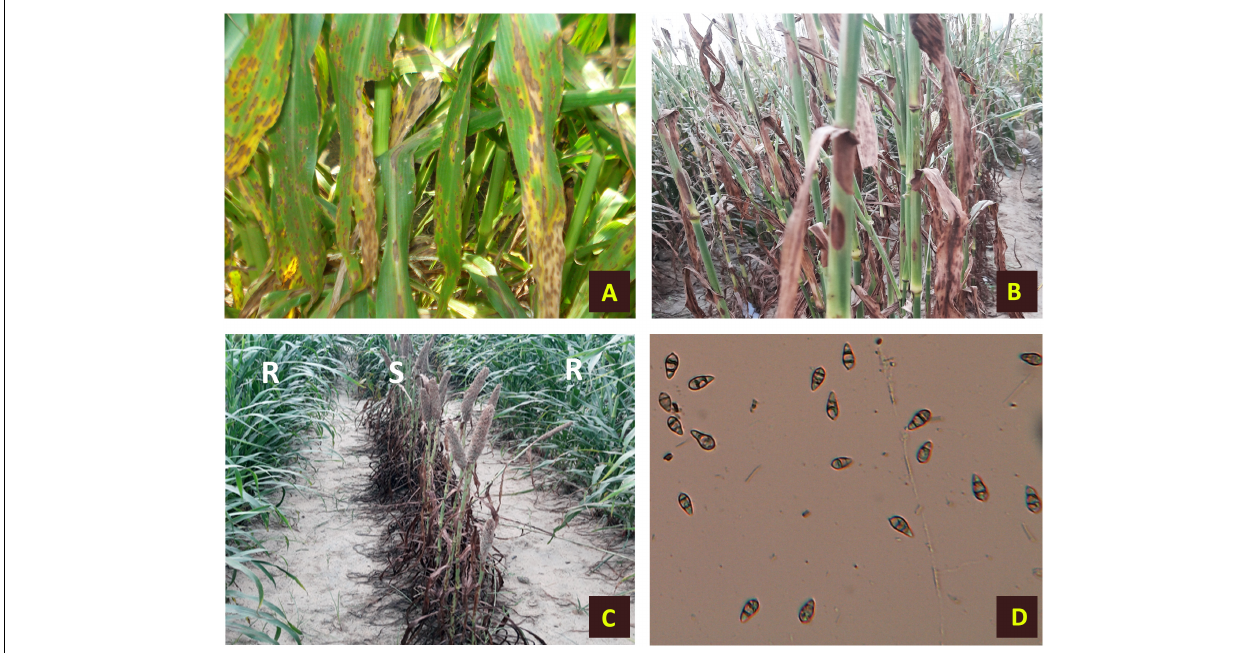
FIGURE 1 | Symptoms of foliar blast on infected pearl millet plants. (A) Infected leaves. (B) Sheath and stem infection. (C) Infected plants along with resistant lines. (D) Conidia of Magnaporthe grisea